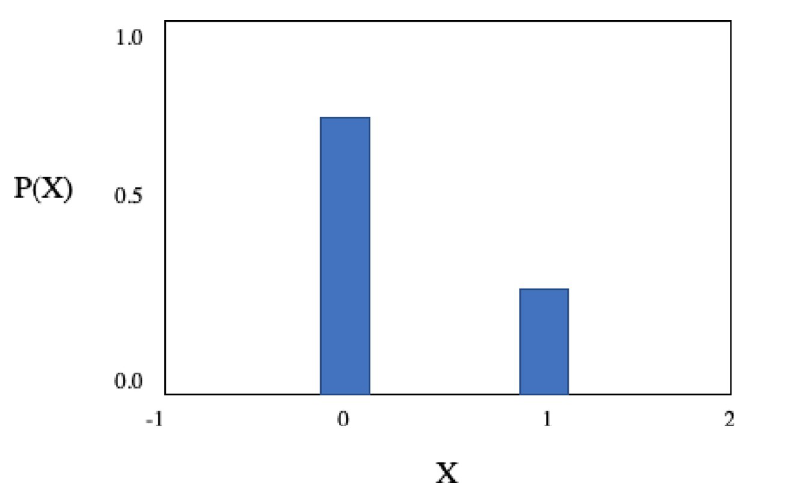
Fig 22. P(X) for the Bernoulli distribution with P(1) = 0.2 and P(0) = 1—P(1) = 0.8. Method Constraint 1: Entropy simulation and uncertainty measurement. Simulated Uncertainty. The first constraint is limited by the entropy. The input parameters for the Kelly function f � are the Wining probability P and the expected net-odds b for the Bernoulli trial W is decreased by a fixed constant rate of 0.0001 at each interaction. The value B . The value of P W b is measured as the ratio of average improvements of the positive interactions divided by the average reduction of the negative interactions. The result of this function is the percentage of the useful side information available in a noisy channel. In Table 8 we have an example for the Kelly criterion calculation.